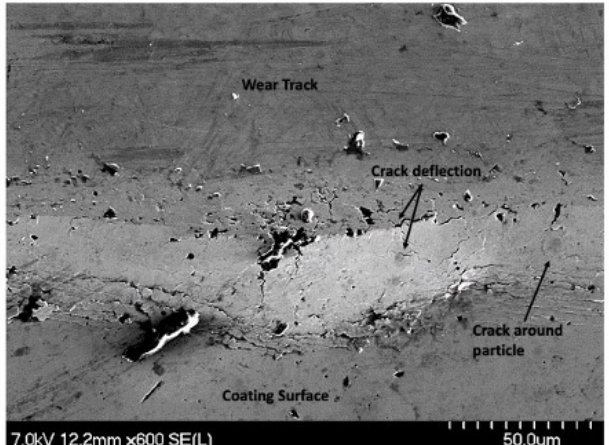
Figure 29. Image of Particle-Crack Interaction on the 100 Pass Wear Track on the 4 μ m Thick Ni-P- NiTi Coating.